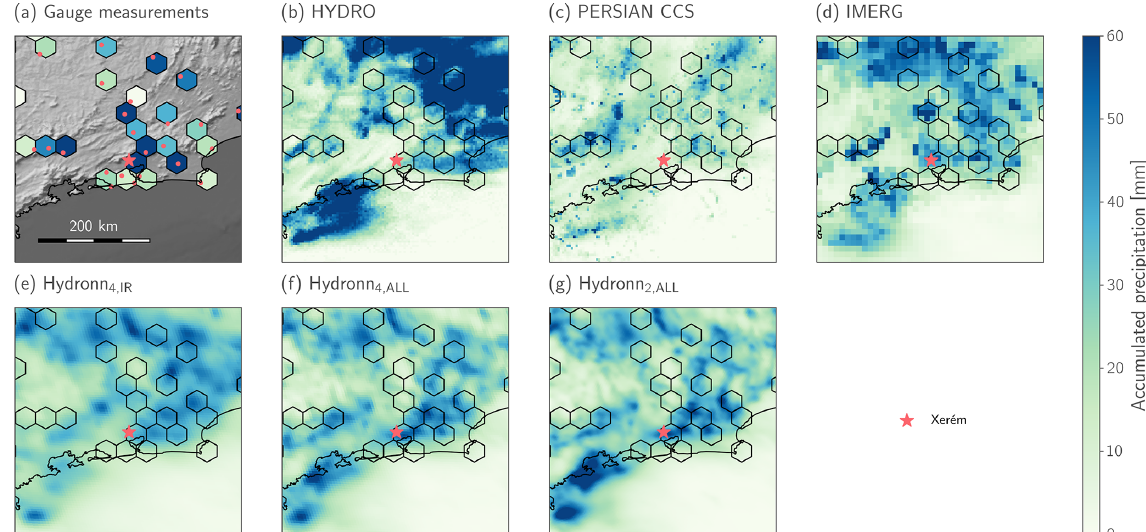
Figure 18. Retrieved precipitation accumulations for an extreme precipitation event in the city of Duque de Caxias in the state of Rio de Janeiro. Panel (a) shows gauge-measured precipitation accumulations using colored hexagons. Locations of the gauges are marked using red points. The red star marks the location of the Xerém neighborhood of Duque de Caxias in which the gauge station closest to the reported flooding is located. The remaining panels show the retrieved-precipitation accumulations for the tested retrieval algorithms.